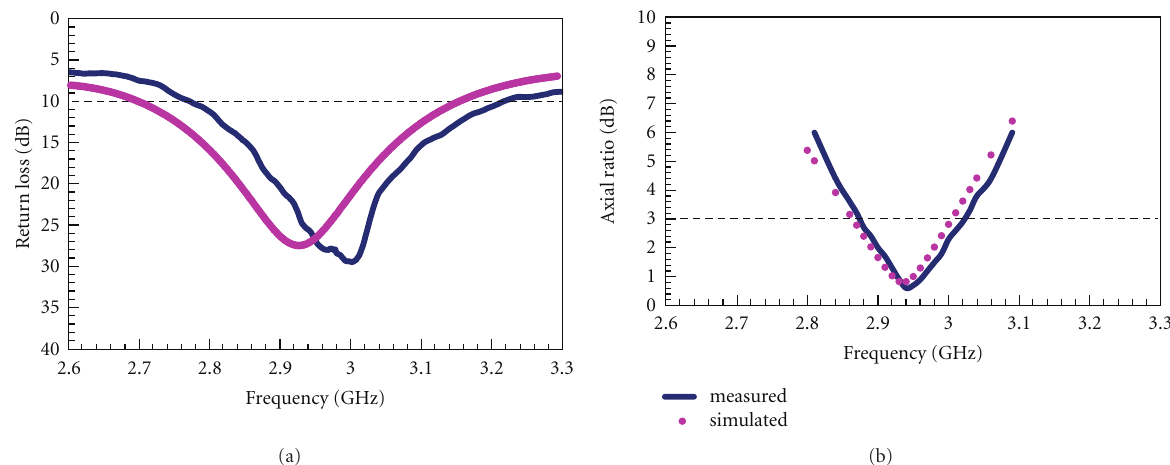
Figure 2: Measured and simulated results for the single CP ring-slot-coupled microstrip antenna. (a) Return loss. (b) Axial ratio.